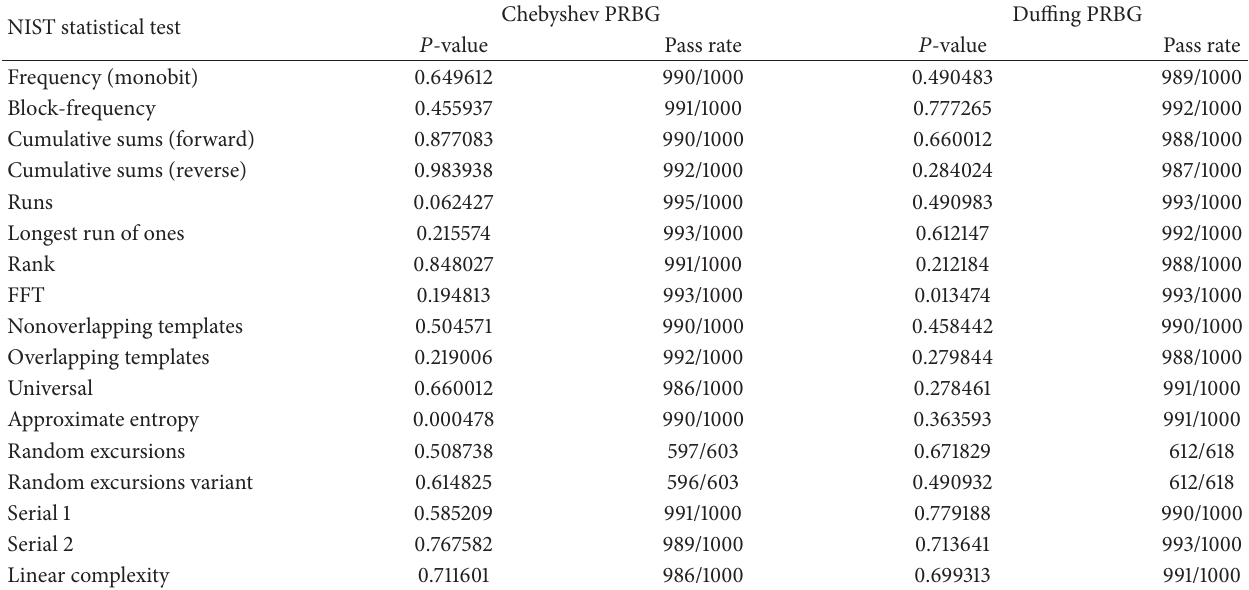
Table 1: NIST statistical test suite results for 2 × 1000 sequences of size 10 6 -bit each generated by the proposed Chebyshev polynomial based pseudorandom bit generator and Duffing map based pseudorandom bit generator.